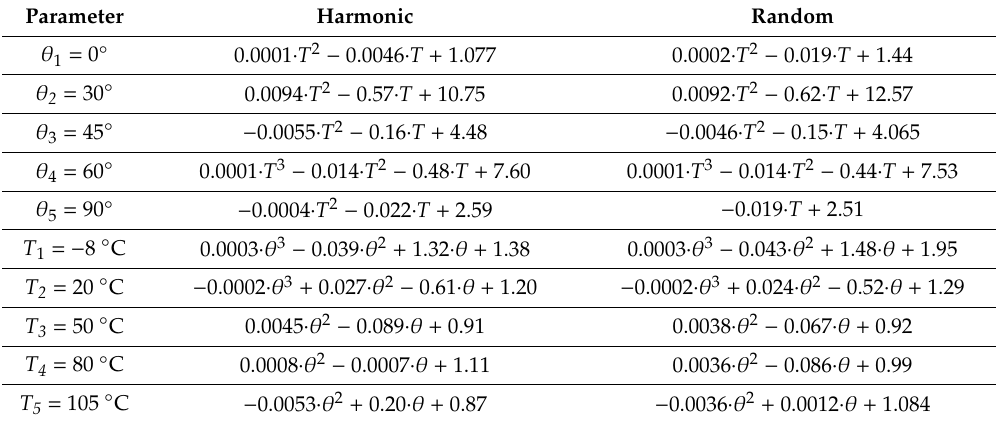
Table 7. Curve-fitted polynomial function of the first modal damping coe ffi cient ( ξ 1 ) with respect to the parameters of interest.